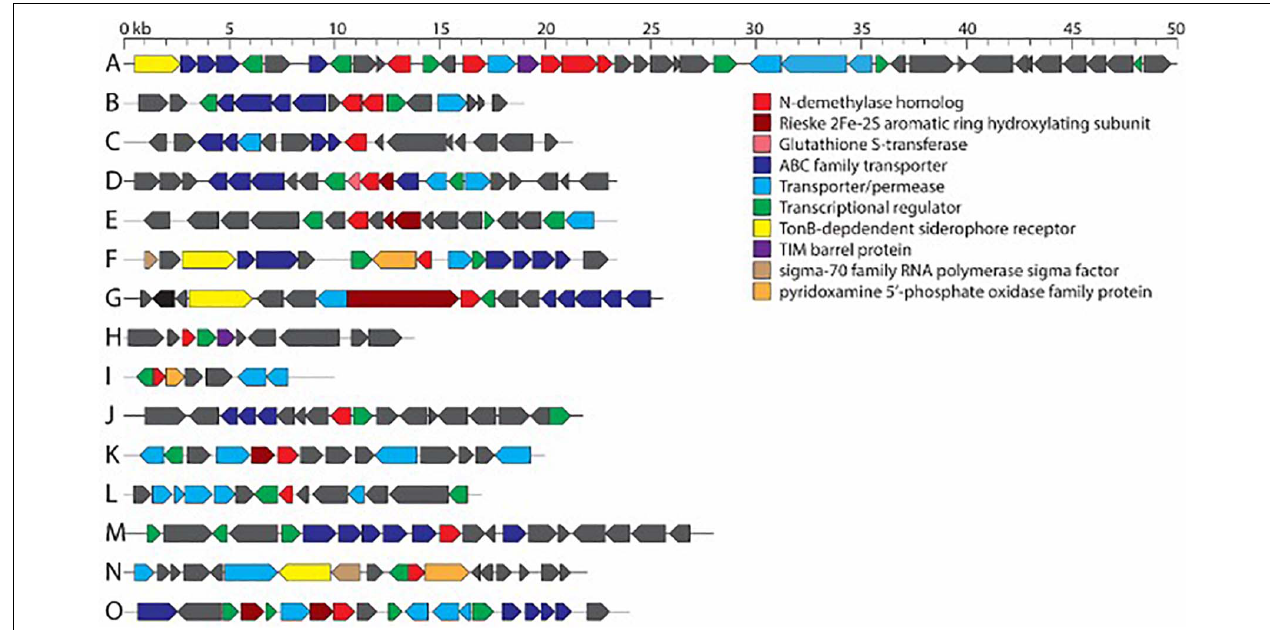
FIGURE 2 | . Consensus gene clusters containing N -demethylase genes from bacterial isolates in this work. (A) ndmABCDE cluster from Pseudomonas sp. S31, S32, S37, S60, and Pseudomonas parafulva . (B) ndmAD cluster from Erwinia sp. S38, S43. (C) ndmA cluster from Bacillus aryabhattai . (D) ndmC gene cluster from Acinetobacter sp. S40, S54, S55. (E) ndmD gene cluster from Acinetobacter sp. S40, S54, S55. (F) ndmE gene cluster from Ochrobactrum sp. S45, S46. (G) ndmD gene cluster from Pseudomonas aeruginosa . (H) ndmE gene cluster from Pseudomonas aeruginosa . (I) ndmE gene cluster from Pseudomonas sp. S30, S75. (J) ndmD gene cluster from Erwinia sp. S63. (K) ndmD gene cluster from Pseudomonas sp. S44. (L) ndmE gene cluster from Pseudomonas sp. S44. (M) ndmA gene cluster from Delftia lacustris . (N) ndmD gene cluster from D. lacustris . (O) ndmE gene cluster from D. lacustris . Genes in each cluster are listed in Supplementary Table 4